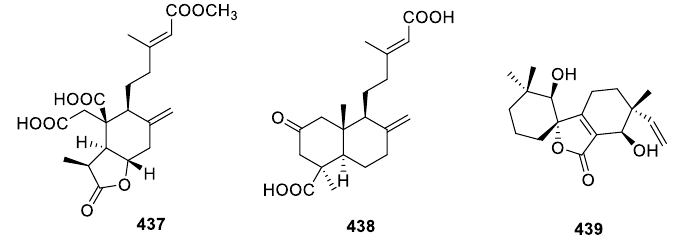
Figure 17. Chemical structures of diterpenoids ( 437 – 439 ).